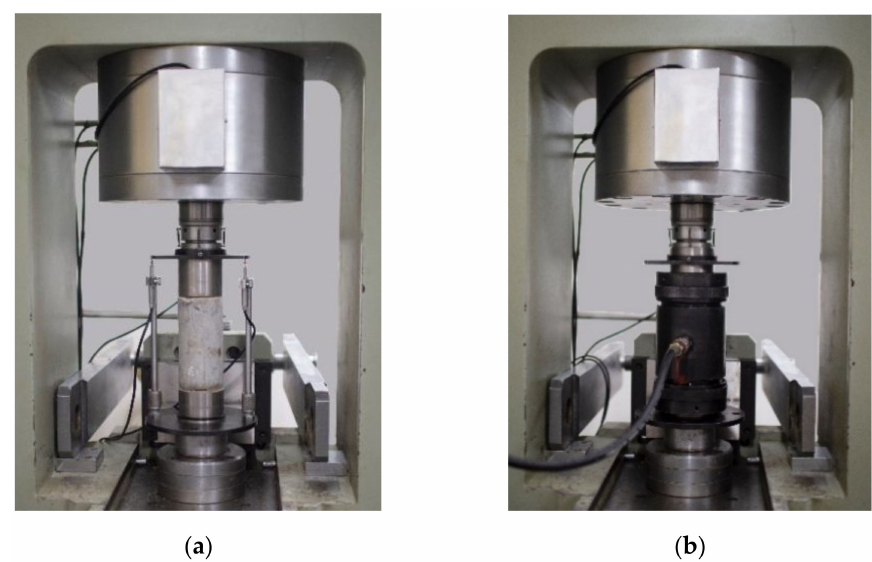
Figure 1. Test setup. ( a ) Uniaxial compression tests. ( b ) Triaxial compression tests.